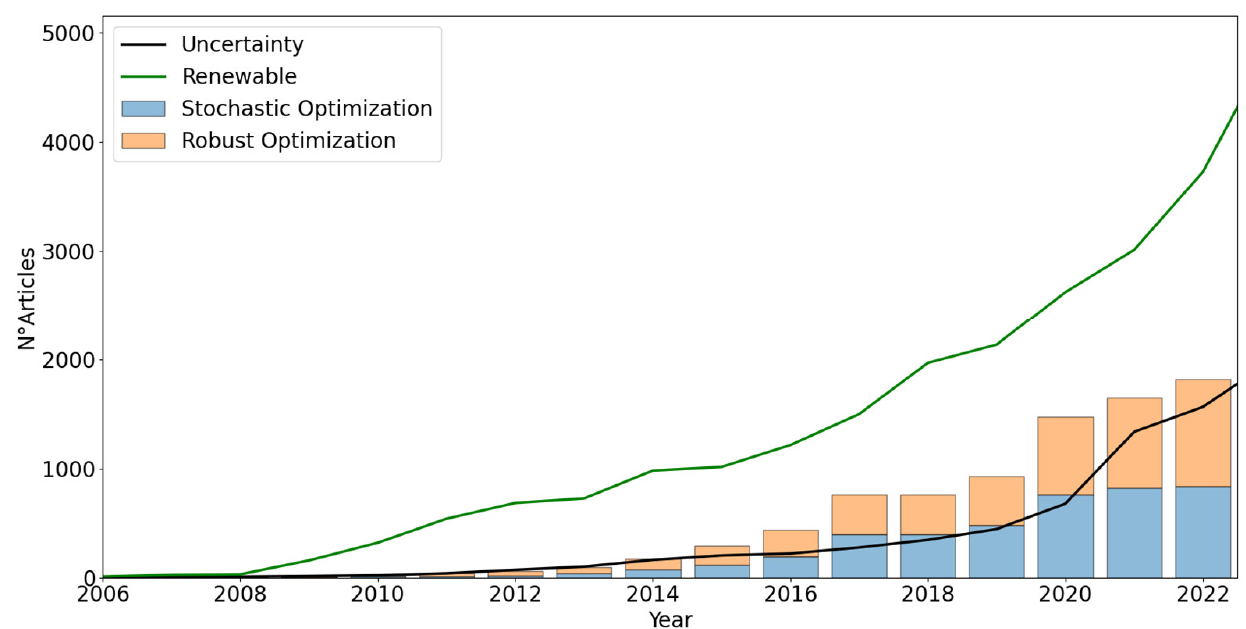
Figure 3. Comparison between the yearly number of articles matching with “renewable” (green line) and “uncertainty” (black line) keywords. The bars represent the number of articles in which “stochastic” or “robust optimization” keywords are present.